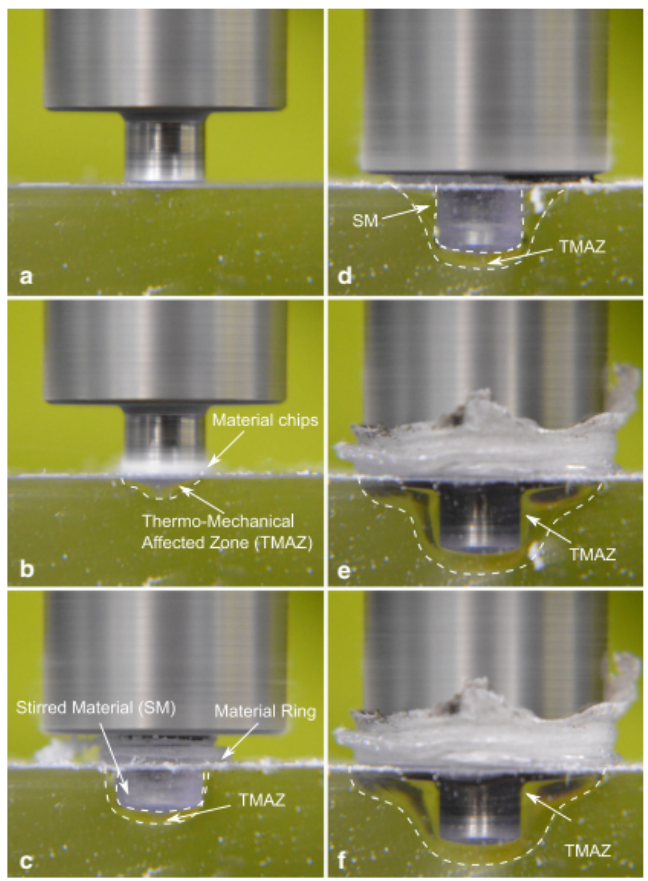
Figure 24. Material flow during FSSW of transparent polymers: ( a ) initial position; ( b ) formation of chips; ( c ) formation of TMAZ under the tool pin; ( d ) enlargement of the TAMZ; ( e ) deep plunging and ( f ) material after dwell. Materials 2020 , 13 , x FOR PEER REVIEW